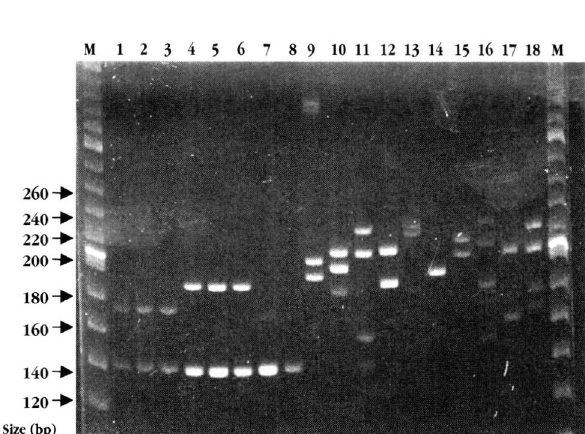
Fig. 1. - Results of the PCR amplification using TRBPA primers on different trypanosome isolates. M: Molecular weight marker (MWM) 100/20 base pair (bp) ladder. Lane 1 to 8: 7". b. gambiense group 1; lane 9 to 12: T. b.